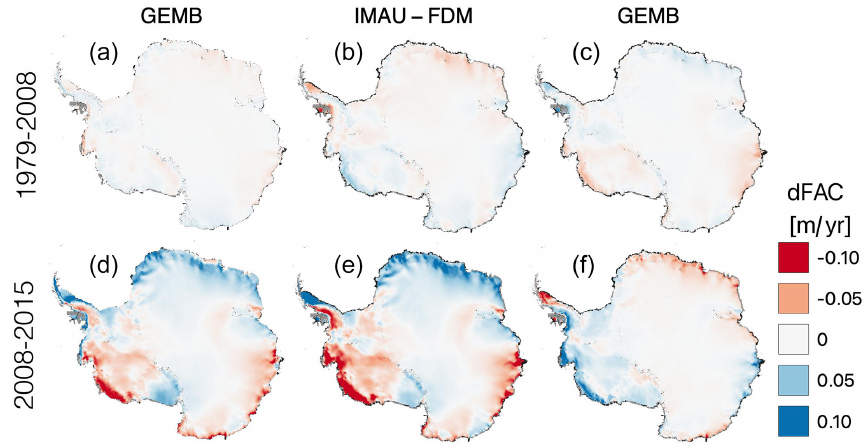
Figure 10. Rate of firn air content change (dFAC) for the Antarctic Ice Sheet as modeled by GEMB (a, d) and IMAU-FDM (b, e) , as well as their difference (c, f) . Rates for the period 1979–2008 are shown in panels (a) – (c) , and rates for the 2008–2015 period are shown in panels (d) – (f) .